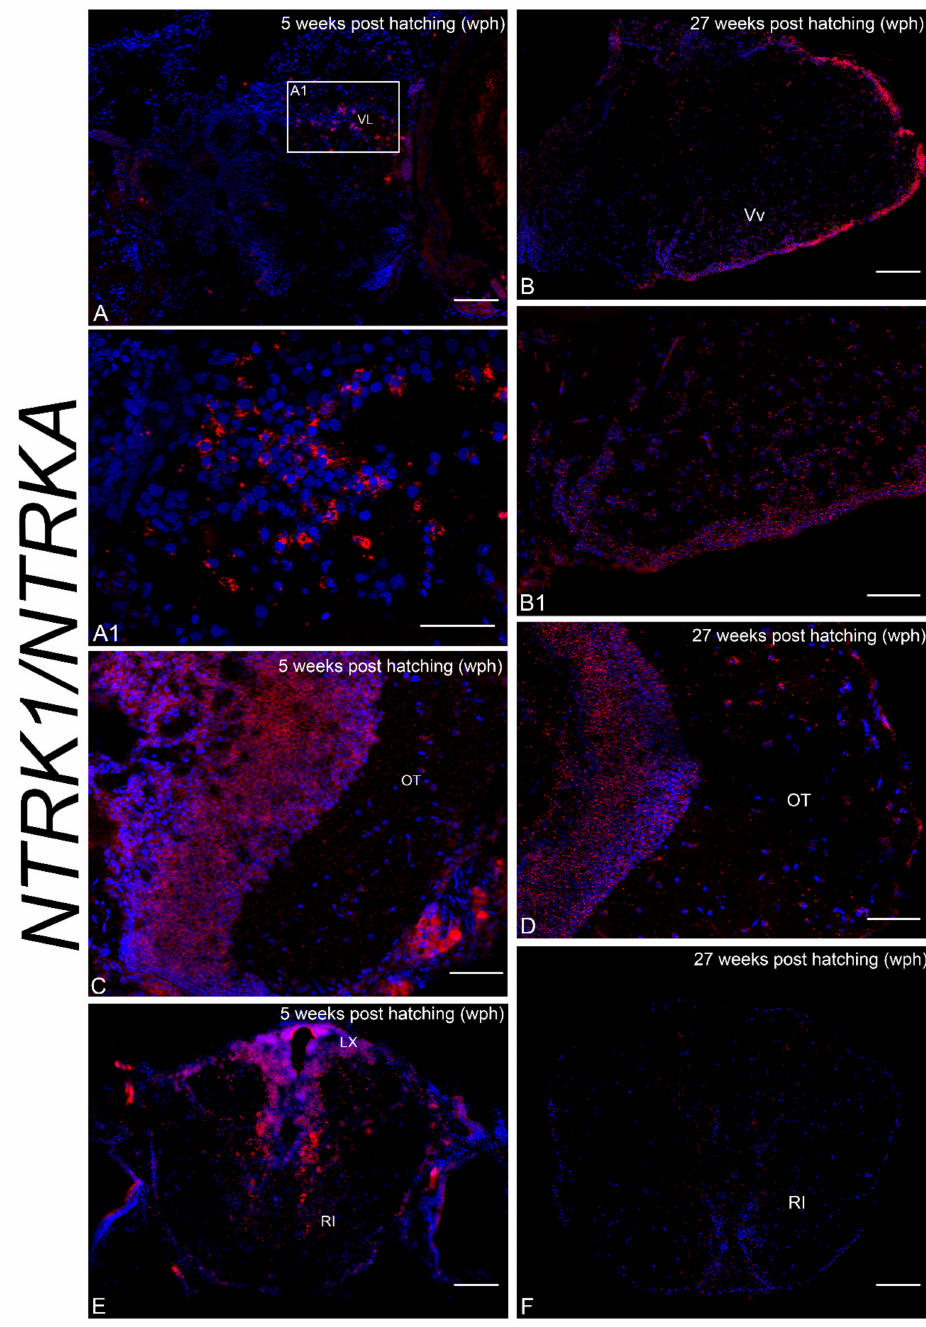
Figure 5. NTRK1 / NTRKA mRNA in the brain of young and old N. furzeri . ( A ). Transverse section of caudal telencephalon of young animals displaying intense labeling in neurons of the lateral thalamic nucleus. ( A1 ). Higher magnification of the rectangle in A showing positive neurons of the lateral thalamic nucleus. ( B ). Transverse section of caudal telencephalon of old animals displaying intense labeling in neurons of the ventral zone of the telencephalon. ( B1 ). Higher magnification of B showing positive neurons of the ventral zone of the telencephalon. ( C,D ) Numerous positive cells in the periventricular gray zone of the OT and very few cells in the more superficial layers of young ( C ) and old ( D ) animals. ( E,F ). Overview of the hindbrain of young and old animals showing ntrk1 expressing neurons in the vagal lobe, along the caudal part of the rhomboencephalic ventricle and in the caudal reticular formation of young animals, and faint labeling along the ventricle and in the reticular formation of old animals. Abbreviations: ventro-lateral thalamic nucleus (VL). Scale bars = A, B, F = 2.5 µ m; B1, D, E = 50 µ m; A1, C = 100 µ